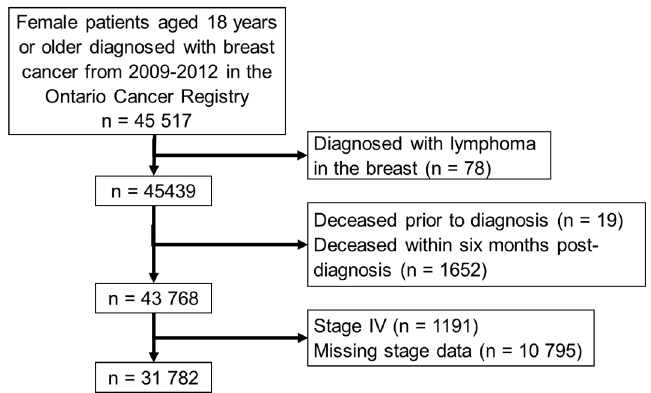
Figure 2. Patient inclusion/exclusion criteria. Table 1. Cohort Description.